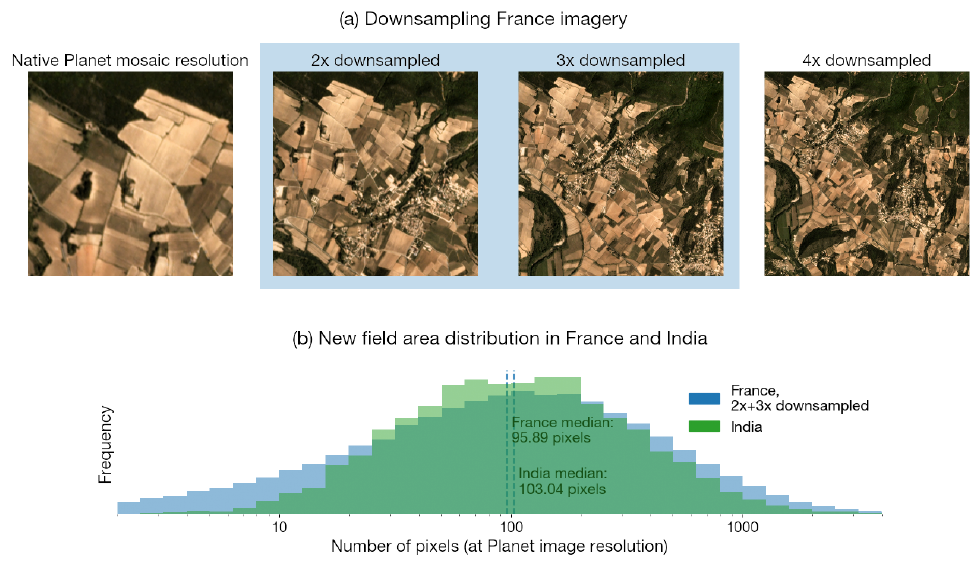
Figure A4. Downsampling France imagery to match Indian field sizes. ( a ) We transformed the France dataset by downsampling PlanetScope imagery 2 × and 3 × and combining the two sets of images. ( b ) As a result, the transformed France field size distribution (as measured by PlanetScope pixels per field) matches the India distribution more closely than the original (Figure